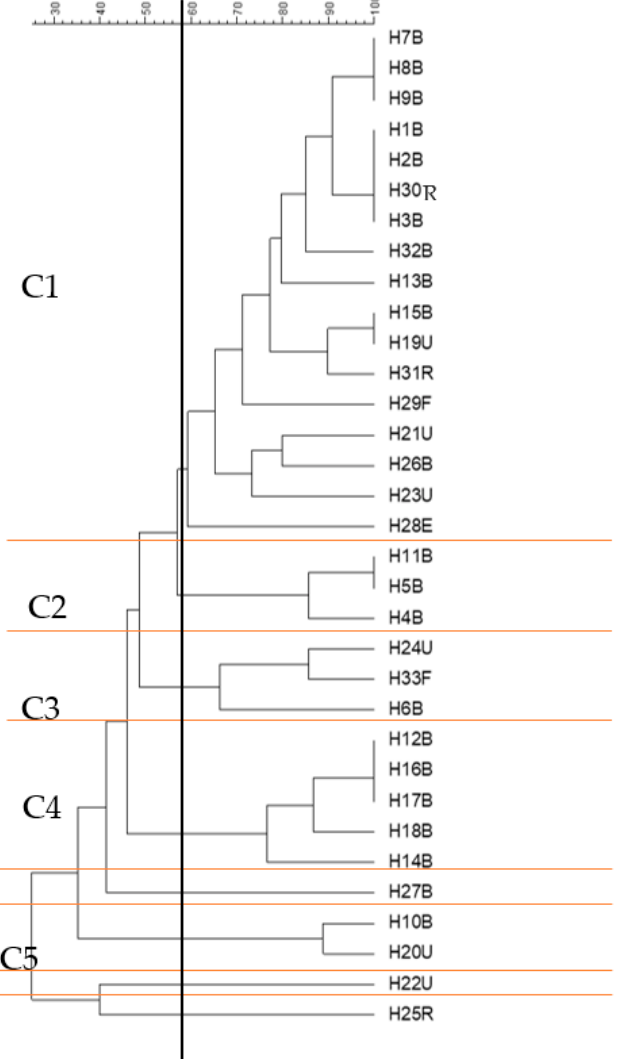
Figure 5. ERIC-PCR genotyping of 33 E. coli isolates from different clinical samples (clusters shown at 58% similarity level). The dendrogram was produced using the UPGMA algorithm based on the Dice similarity coefficient. H for human; B, U, F, R and E are specific designations to show the source of the sample. For example, B refers to blood, U is for samples collected from urine, F is for the sample collected from faeces; R is for samples collected from sputum from the respiratory system; and E is for the isolate collected from an ear infection. C refers to the cluster number. Clusters C1-C5 were formed at a 58% similarity level, as designated using AMOVA analysis. The horizontal black line divides each main group (C1-C5) that clustered at the 58% similarity threshold, which is indicated by the vertical black